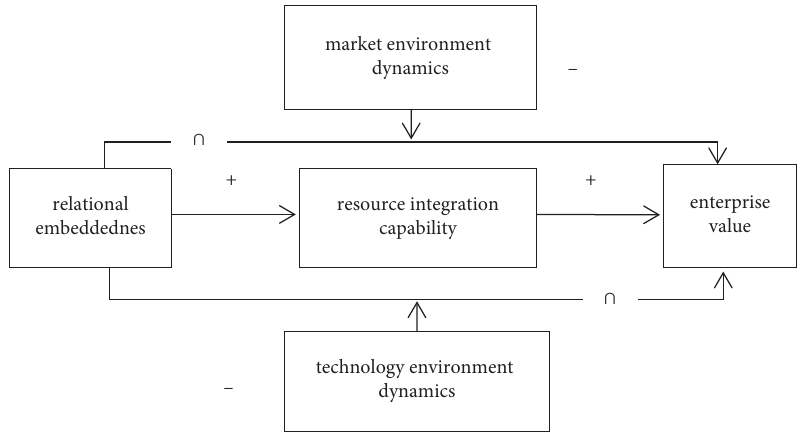
Figure 1: Conceptual